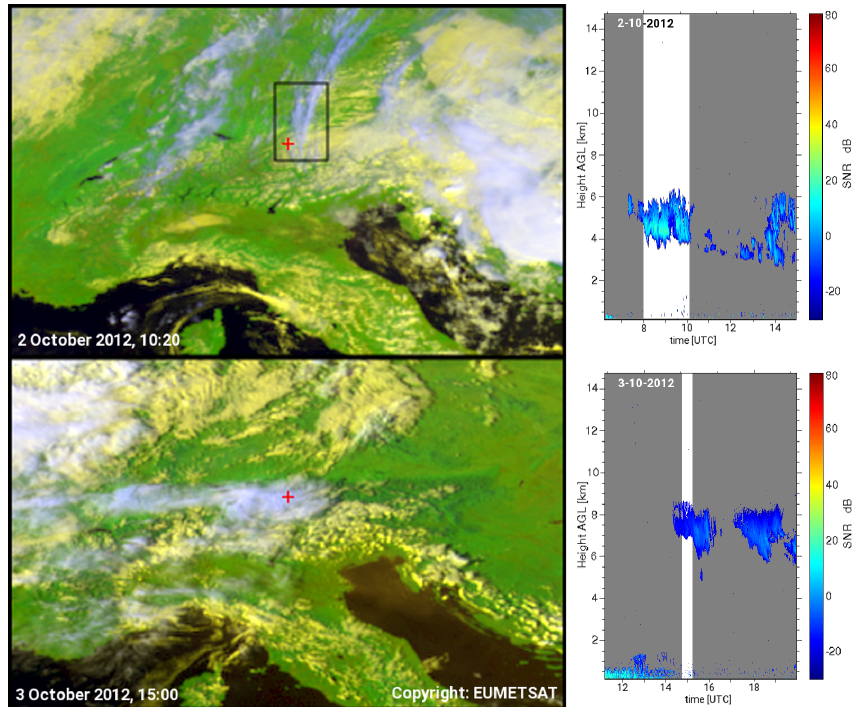
Figure 7. Left panels: central Europe in a Meteosat false colour composite (R: 0.6µm; G: 0.8µm; B: inverted 10.8µm) for 2 October 2012, 10:20UTC (left top panel), and for 3 October 2012, 15:00UTC (left bottom panel). Use of thermal-infrared information leads to bluish (cold, high clouds) and yellowish (warm, low clouds) colours. The red cross marks the position of UFS at Zugspitze, the black box the approximate location of MODIS data granule in Fig. 10. Right panels: related cloud radar cross sections from the vertical pointing Ka-band METEK MIRA 35 on UFS Schneefernerhaus (height 2650ma.s.l.) around time of specMACS measurements. White areas label the time periods with ground